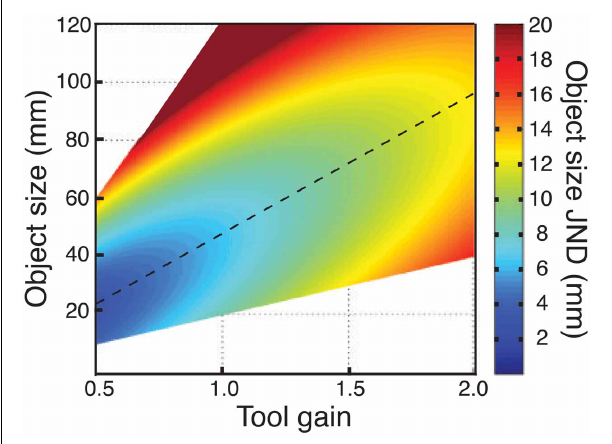
FIGURE 10 | Effects of tool gain and object size on haptic size sensitivity. The figure plots object size JNDs as a function of both object size, and tool gains. Continuous data were obtained by using the fit to the empirical data from Experiment 1 (no-tool condition), and assuming again that sensitivity in object-size units was a straightforward combination of sensitivity to hand opening and the effects of tool geometry ( Figure 1 ). The regions of the figure where no data are plotted correspond to hand openings beyond our measured data. JNDs ≥ 20mm are not represented accurately, but are plotted as a “flat” dark red